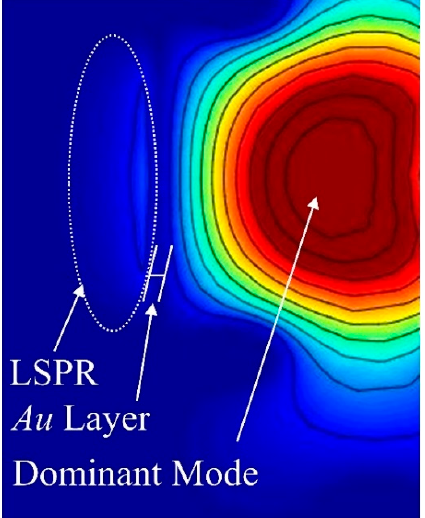
Figure 4. Detail of the LSPR in fiber with SiO (cid:2870) defect.